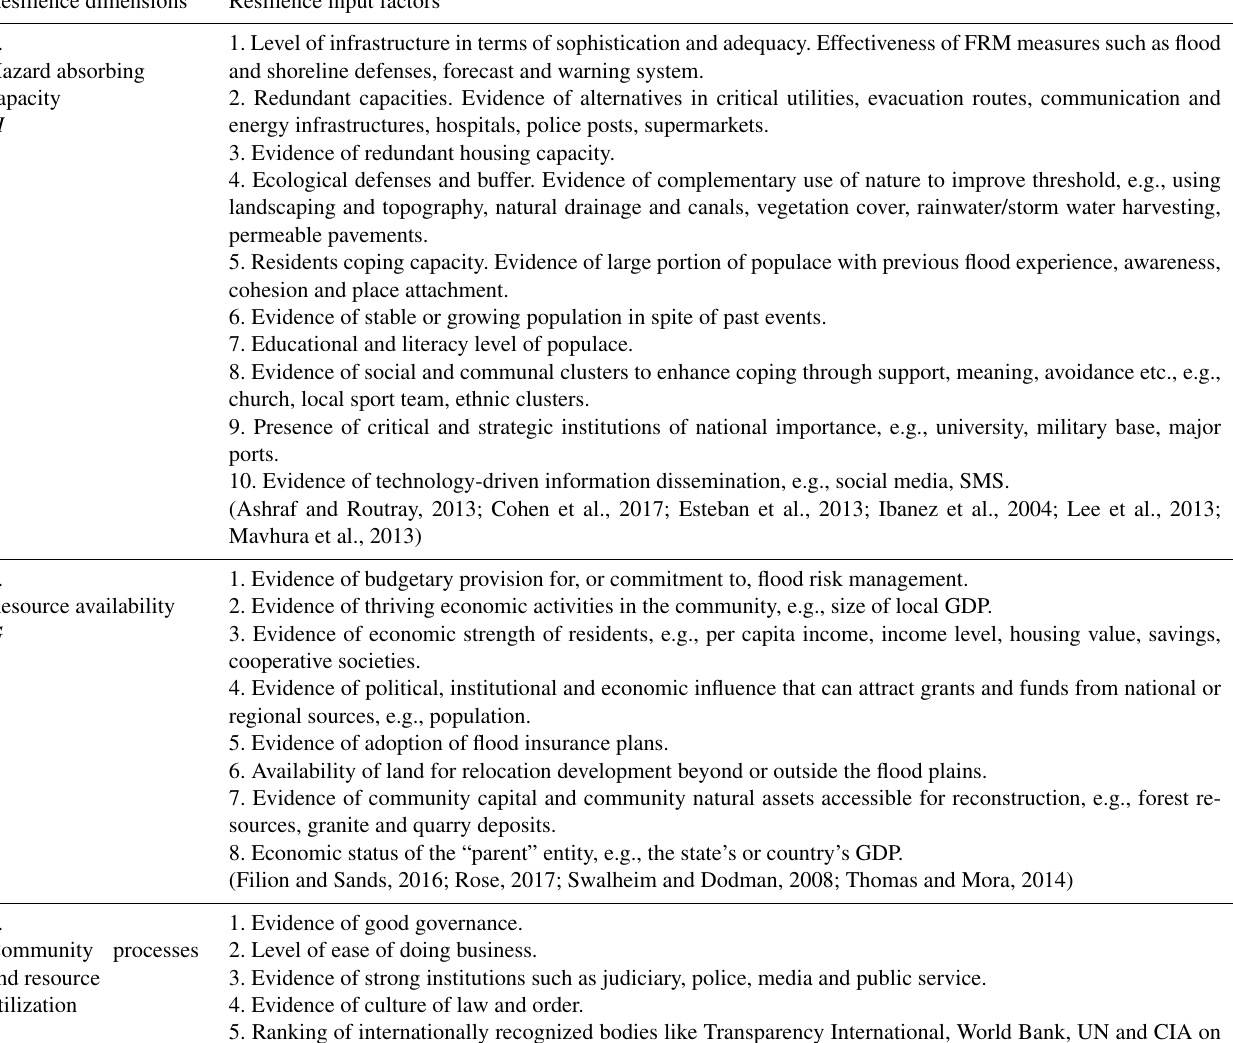
Table 1. Resilience dimensions and descriptions of input factors influencing their states. Resilience